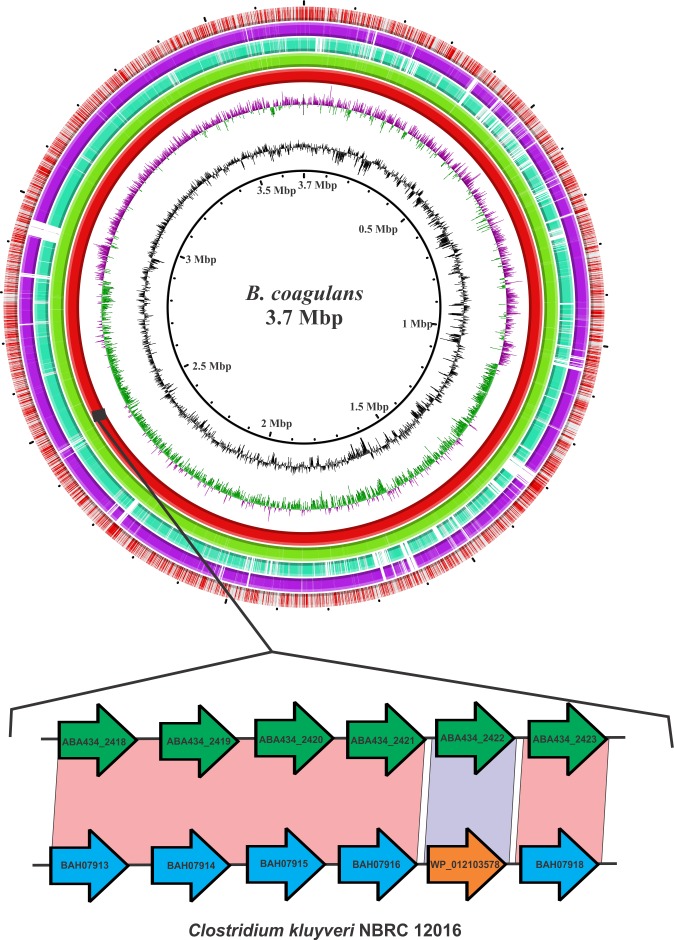
Horizontal gene transfers mapped onto the circular genome for Bacillus coagulans S-lac.Circles (from inside to outside) 1 and 2 represent GC content and GC skew, Circle 3 (red colored) is the genome itself; circle 4 (green colored) represent the Bacillus coagulans 2–6 genome mapped on the Bacillus coagulans S-lac. Similarly, circle 5 (cyan colored) and 6 (magenta colored) are Bacillus coagulans GBI-30 and Bacillus coagulans 36D1 mapped respectively on Bacillus coagulans S-lac. Circle 7 is the adhesion, sporulation and stress-related proteins that have been mapped onto the genome. The genes corresponding to Clostridium kluyueri genome represents the RM Type III system which lies on a phage element that is also present in Bacillus coagulans strain GBI-30.